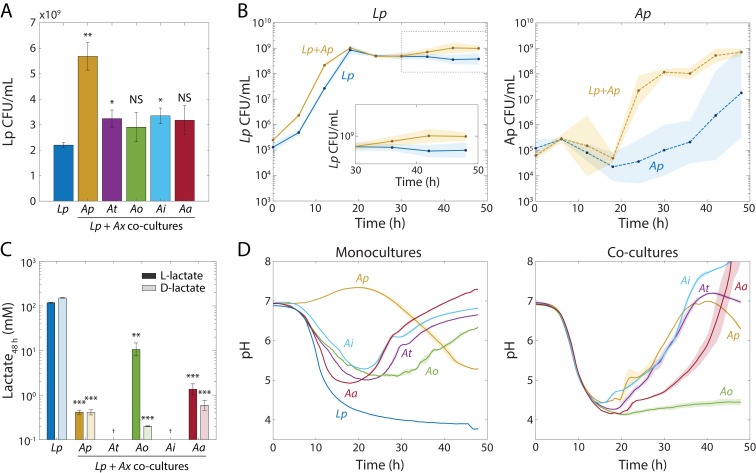
Lp growth during stationary phase in Acetobacter co-cultures is associated with an increase in pH and a decrease in lactate concentration.(A) Co-culturing Lp with Ap, At, or Ai resulted in increased Lp cell density after 48 hr. Co-culturing with Ao or Aa did not significantly increase Lp cell density by 48 hr. Error bars are standard deviation (S.D.) for each condition, n = 3. p-values are from a Student’s two-sided t-test of the difference from the monoculture (*: p<0.01, **: p<2×10−3, equivalent to *: p<0.05/n, **: p<0.01/n, where n = 5 is the number of comparisons; NS: not significant). (B) Co-culturing Lp with Ap resulted in higher Lp cell density in stationary phase, as well as faster growth and shorter lag for Ap. Shaded regions indicate S.D., n = 3. Inset: zoom-in on region inside dashed box highlighting increase in carrying capacity in co-culture. (C) L- and D-lactate accumulated to much higher levels in Lp monocultures than in co-cultures after 48 h of growth, suggesting that Acetobacter spp. consumed Lp-produced lactate. Lactate concentration was measured enzymatically from culture supernatants at 48 hr. Error bars are S.D. for each condition, n = 3. p-values are from a Student’s two-sided t-test of the difference from the monoculture (**: p<2×10−3, ***: p<2×10−4, equivalent to **: p<0.01/n, ***: p<1×10−3/n, where n = 5 is the number of comparisons; †: measurement below limit of detection). (D) The increase in Lp cell density in stationary phase is associated with an Acetobacter-dependent increase in pH early in stationary phase. pH was measured with the pH-sensitive dye 2’,7-bis-(2-carboxyethyl)−5-(and-6)-carboxyfluorescein over time (Materials and methods). Shaded regions indicate S.D., n = 3. Data points were taken every 8.3 min.